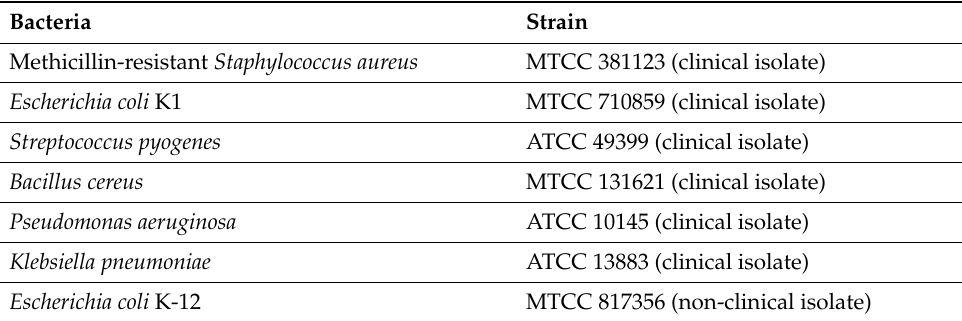
Table 3. Bacteria used in this